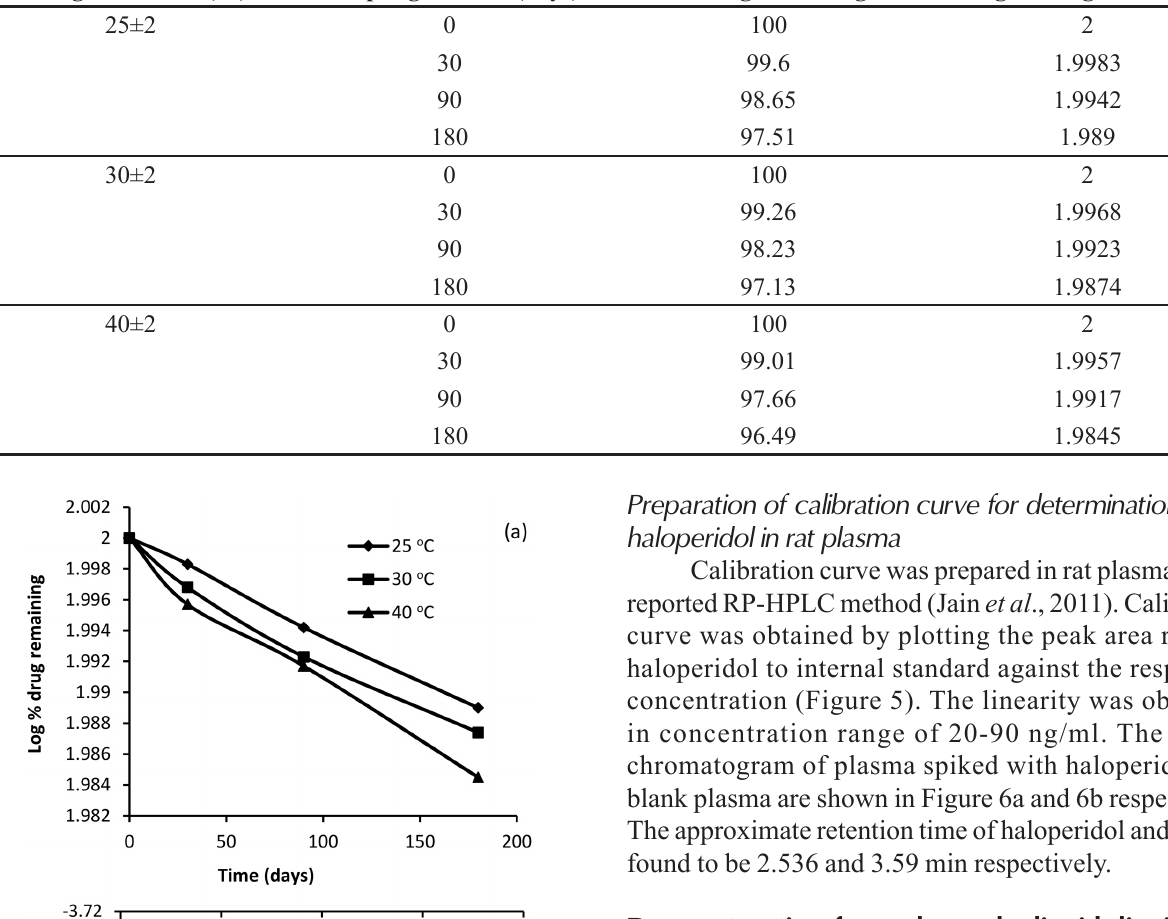
TABLE IV - Degradation of optimized HP- SLNs kept at 25±2 ºC; 30±2 ºC and 40±2 ºC at ambient RH Storage condition ( o C)